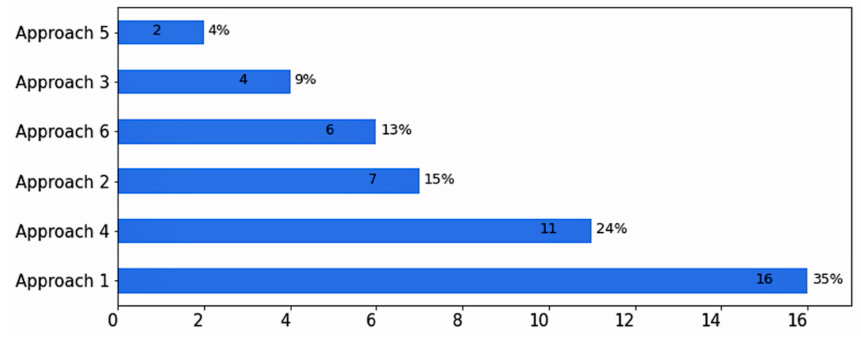
Figure 9. Breakdown of the recognition